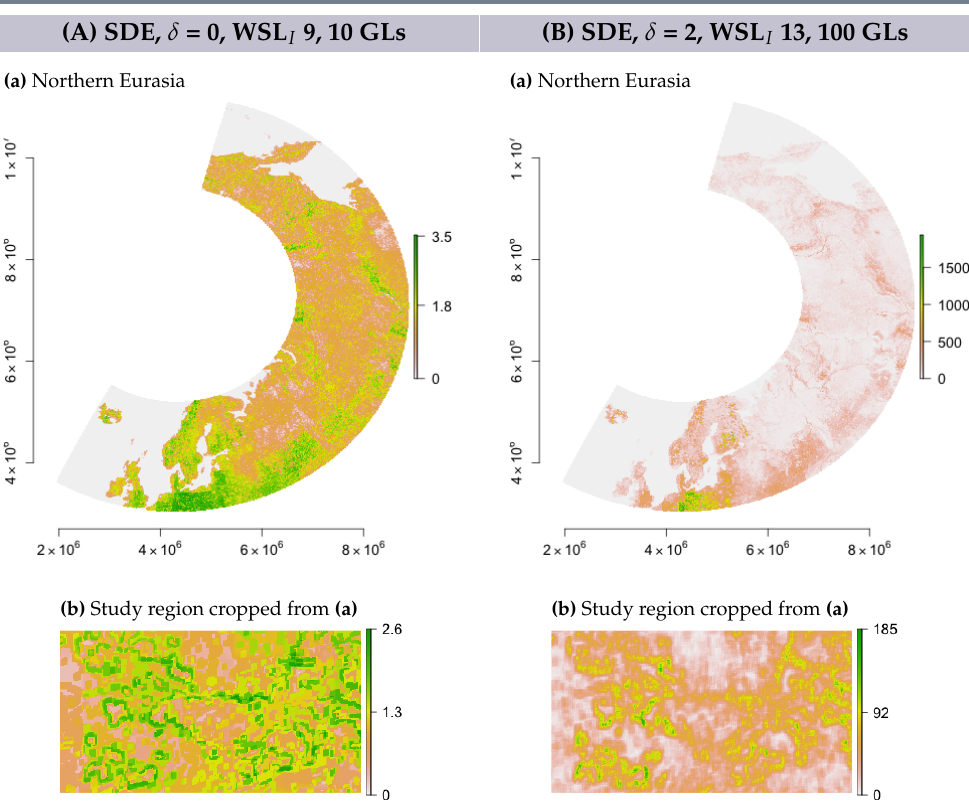
Figure 9. Structural diversity entropy (SDE), (A,B) (a) of northern Eurasia (Lambert azimuthal equal-area projection), (b) of the study region, which was cropped from northern